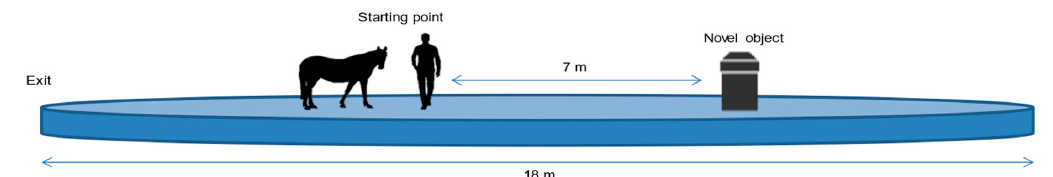
Figure 1. Experimental setup of the test arena as well as the subject’s and the experimenter’s location at the beginning of the trial.